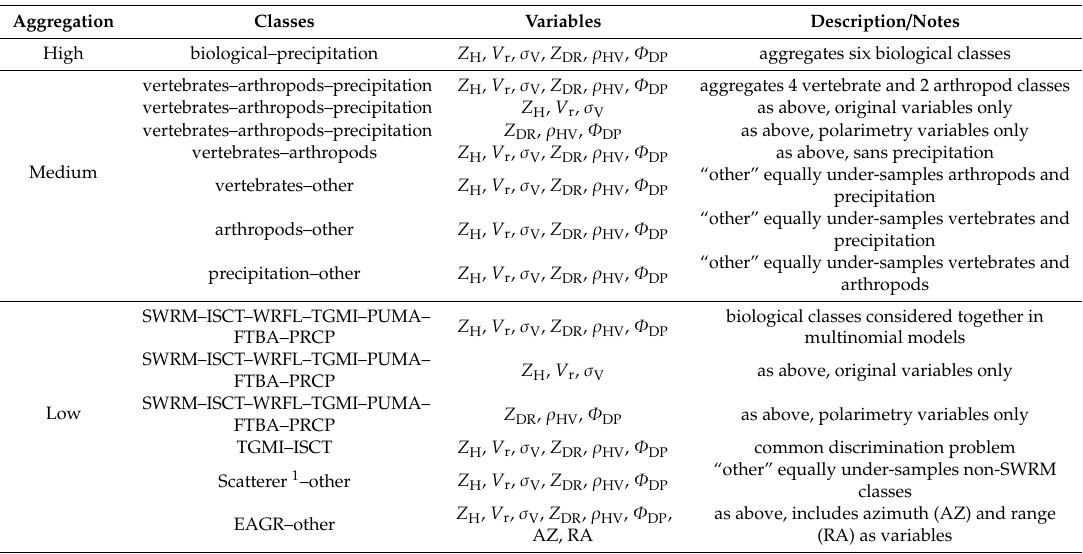
Table 2. Random forest models executed for this project broken down by their level of aggregation, classes in the model, and discriminating